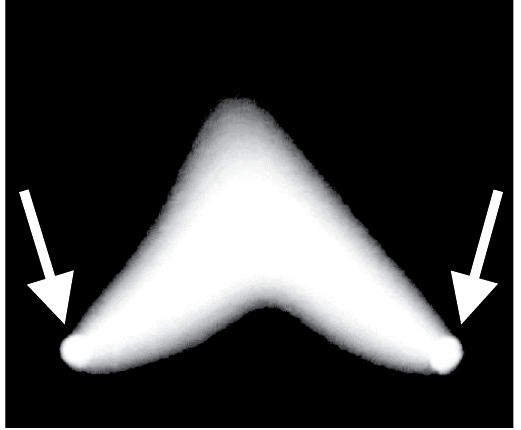
Figure 6. Arc plasma produced between the stainless-steel electrodes with a nail shape under normal atmospheric air is shown.